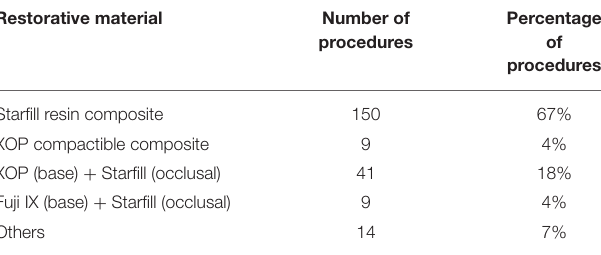
TABLE 2 | Frequencies of materials used for infundibular